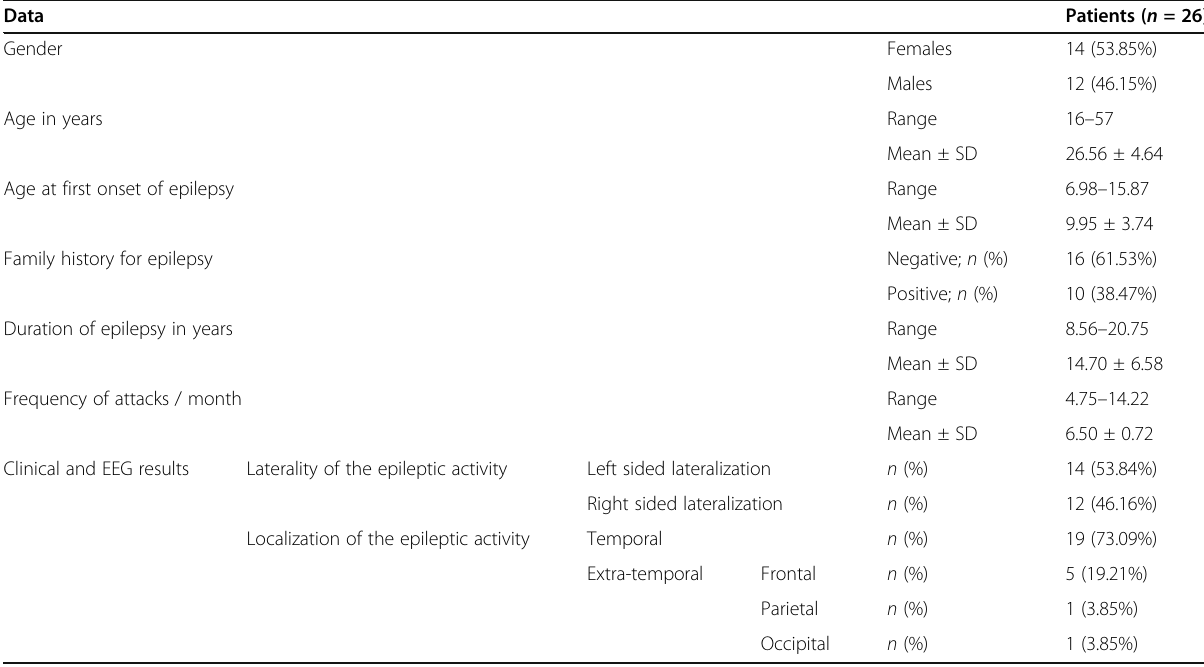
Table 2 Demographic and clinical data of the study participants